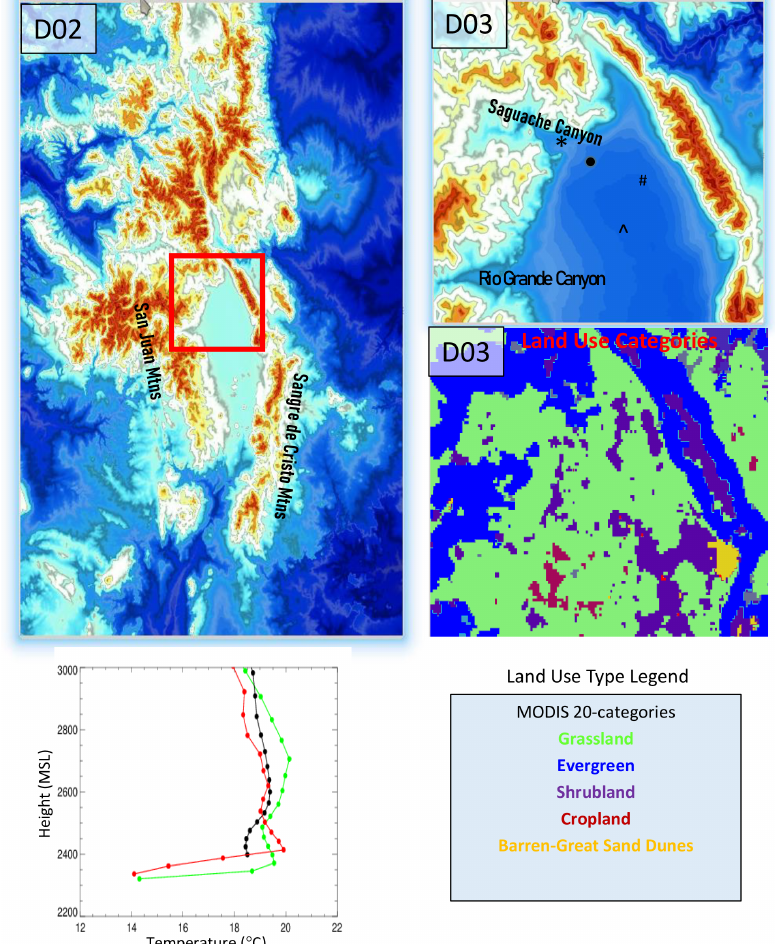
Figure 1. Model terrain for D02 (1km grid spacing) and D03 (111m grid spacing) and land use specification for D03 obtained from the MODIS 20-category dataset. Note that D02 was nested within a mesh with 9km grid spacing when GFS forcing data were used. The symbols “*”, “#” and “ ∧ ” mark the location of the AWOS station at Saguache Municipal Airport (SAG), Moffat observing site (MOF) and Leach Airport locations, respectively, for which high-rate model output data are available. The filled circle marks the location of the NSSL soundings. WRF LES profiles of temperature are given for three grid points (closest to SAG (black), NSSL (red), MOF (green)) for the drainage flow case valid at 06:00MDT on 19 July 2018. The heights of the half levels at each location are indicated by the filled